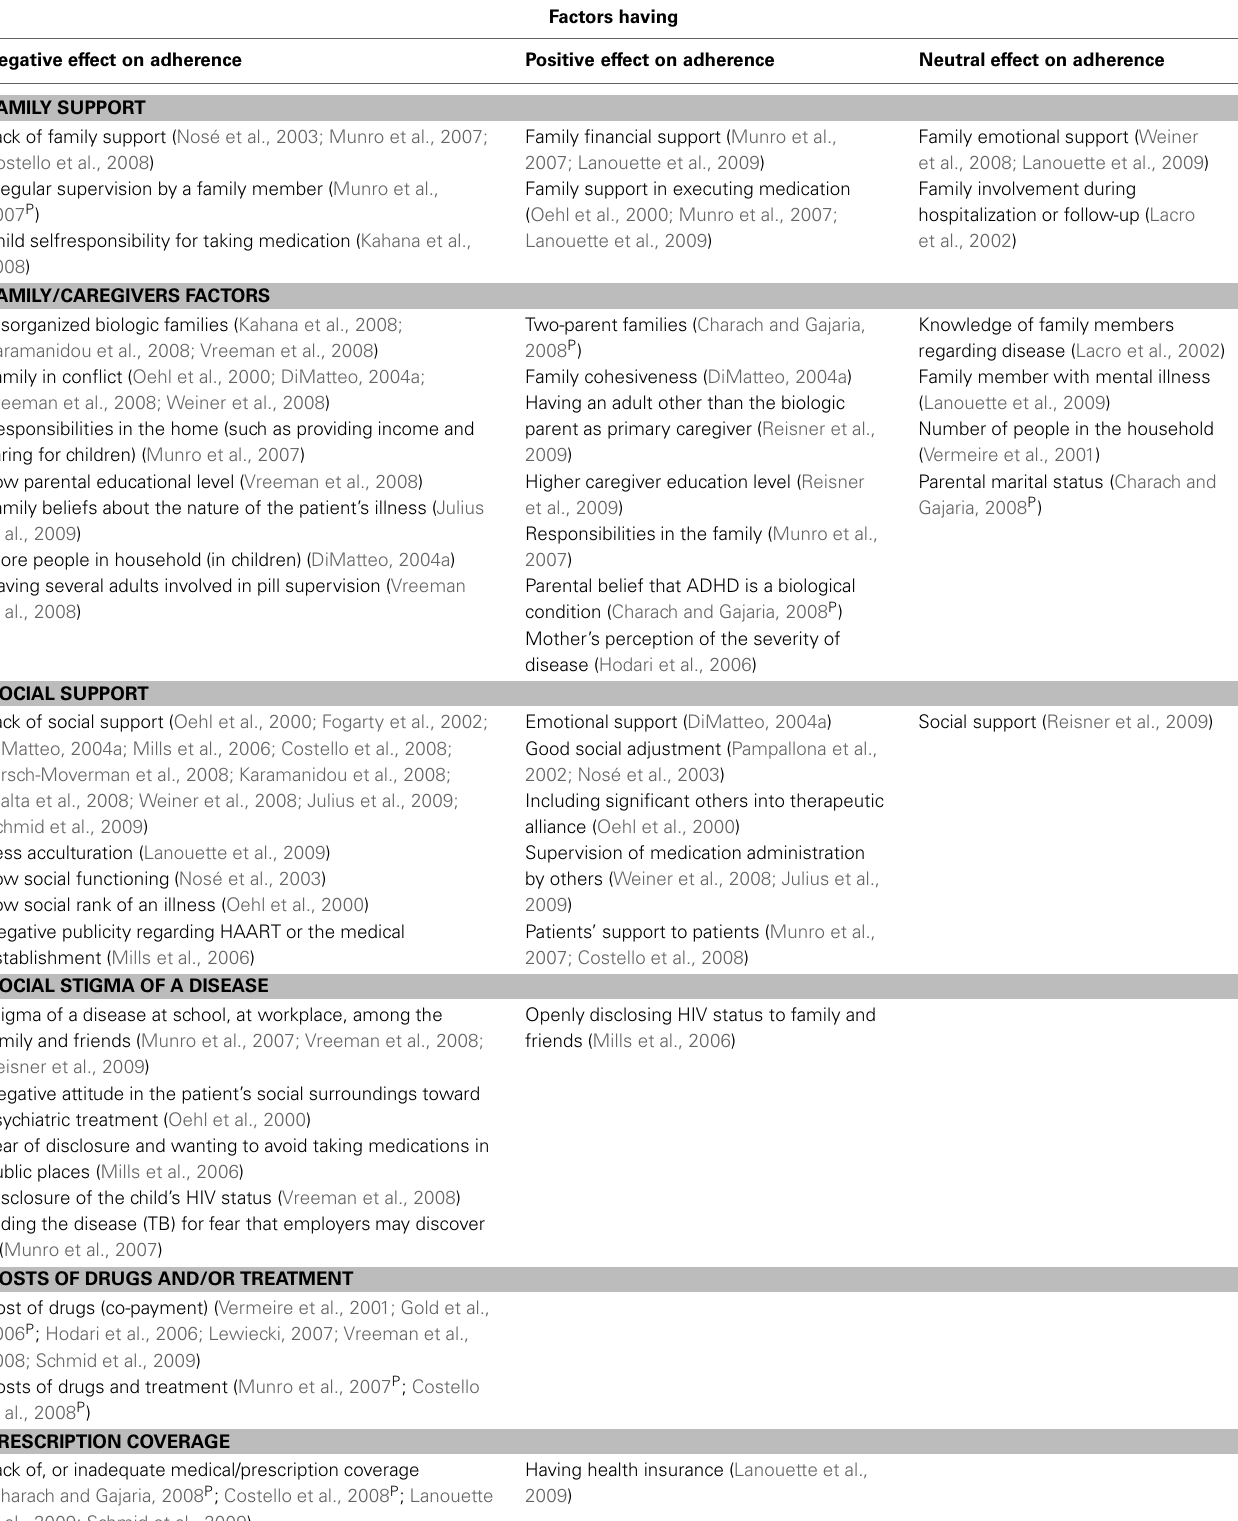
Table 3 | Socio-economic factors affecting